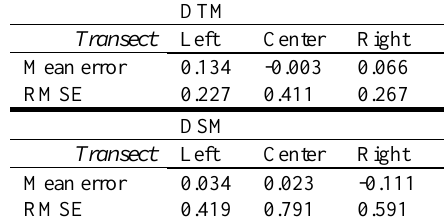
Table 2. DTM and DSM errors